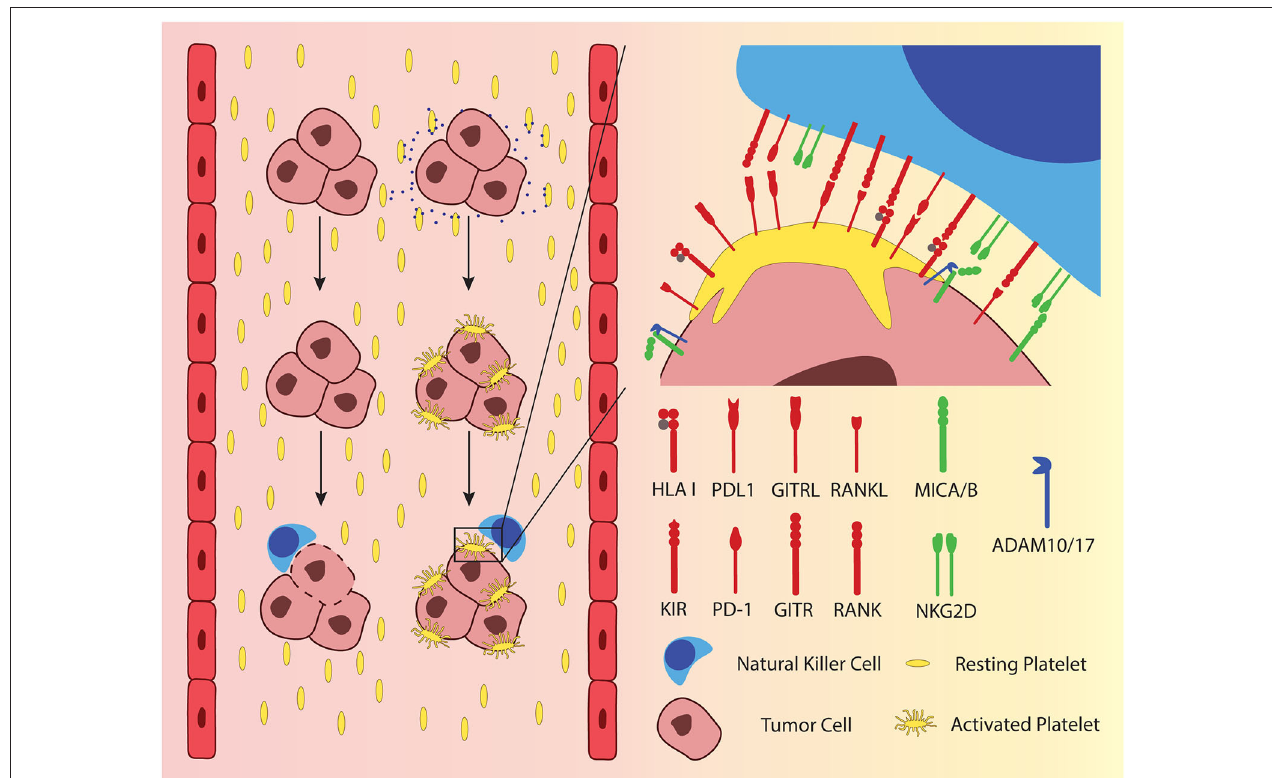
FIGURE 1 | Metastasizing tumor cells exploit platelets as physical and immunological shielding from NK cells in peripheral blood. Platelets are activated upon encountering tumor cells, which release adenosine diphosphate (ADP) and tissue factor (TF), depicted as blue dots. Activated platelets adhere to the tumor cells surface, providing a physical and an immunological shield by presenting ligands to inhibitory NK cell receptors. Moreover, activated platelets exchange surface receptors with tumor cells. Several ligands to inhibitory NK cell receptors have been shown to be passed over from platelets to tumor cells, including HLA class I, glucocorticoid-induced TNF-related protein (GITR) ligand, receptor activator of NF κ B (RANK) ligand and PD-L1. The figure furthermore delineates the shedding of MICA and MICB, which are ligands to the activating NK cell receptor